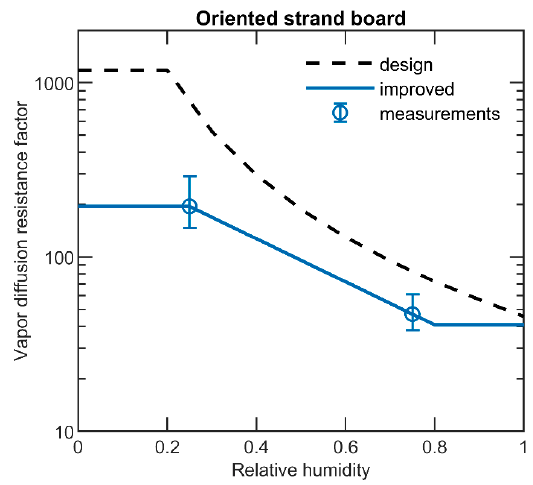
Figure 5. Water vapor diffusion resistance factor measurements and improved model for OSB.